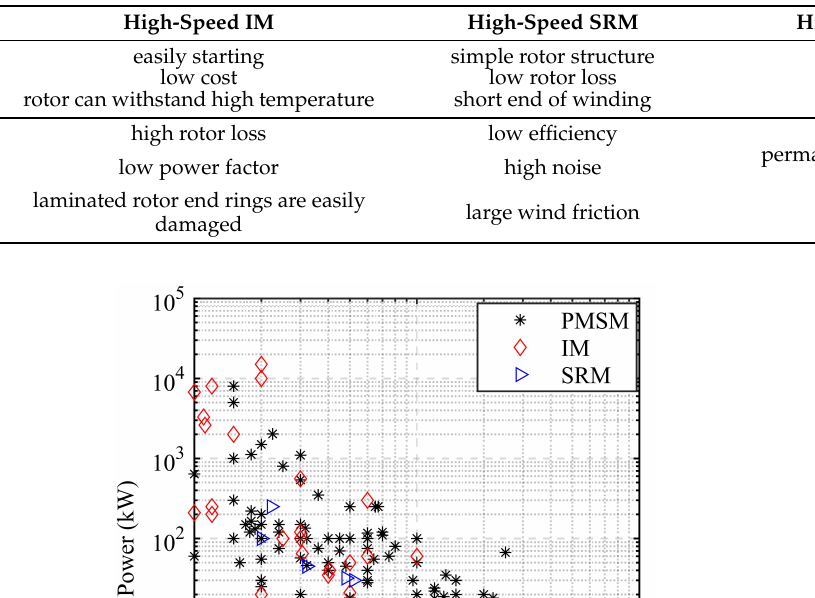
Table 1. Characteristics of various types of high-speed motors.